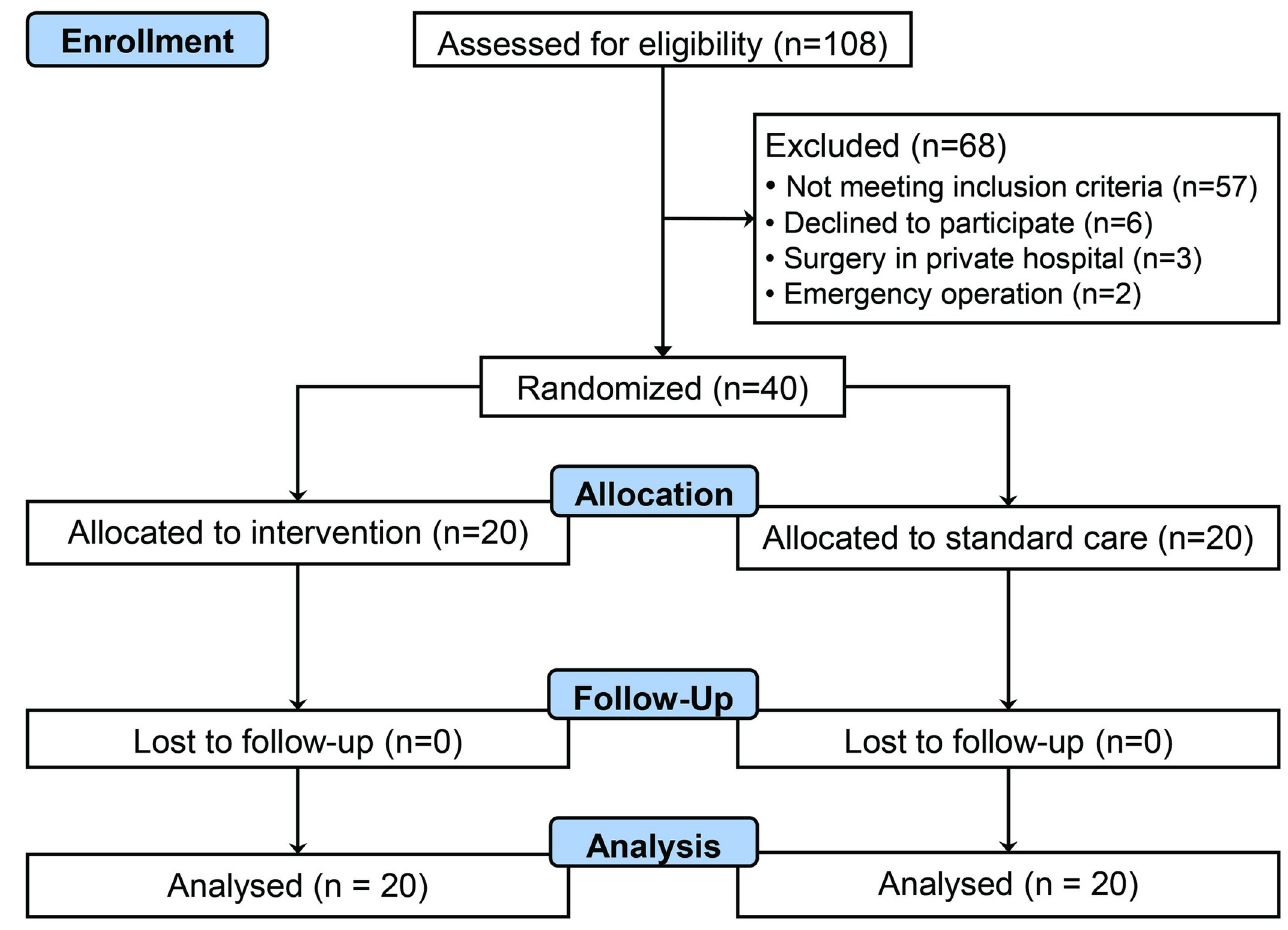
Fig 1. CONSORT diagram of patient